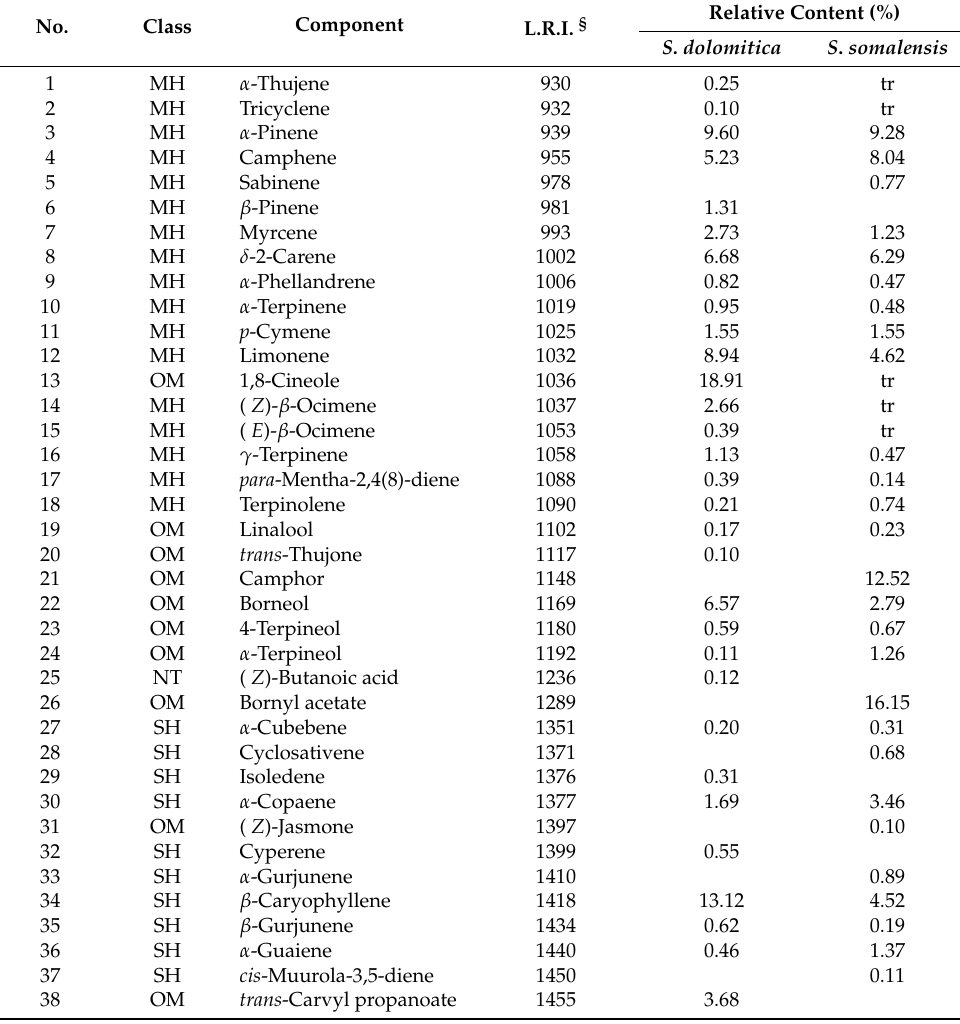
Table 1. EO analysis of Salvia dolomitica and Salvia somalensis aerial